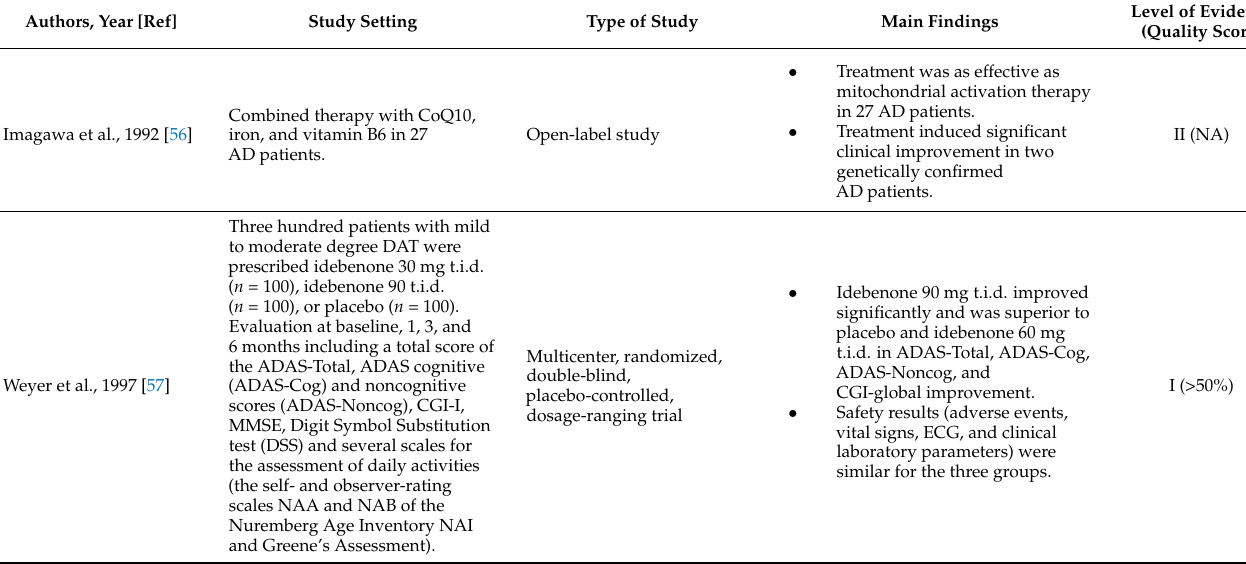
Table 3. Studies describing the effects of COQ 10 supplementation in patients with AD.